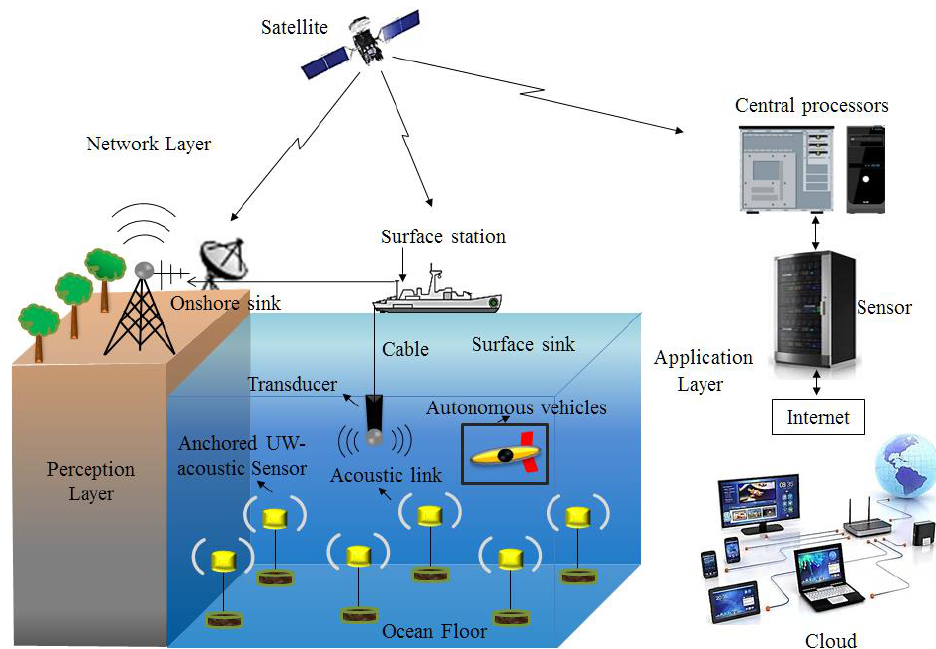
Figure 4. Standard IoUT architecture.